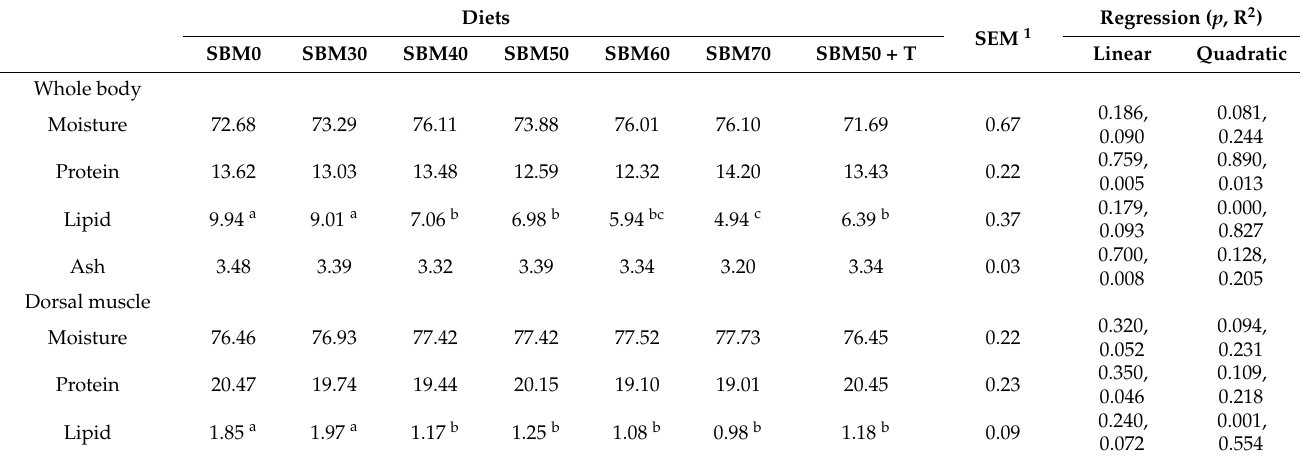
Table 5. Whole-body and tissue proximate composition in juvenile Oplegnathus punctatus fed diets containing different levels of soybean meal (as a % of the wet weight